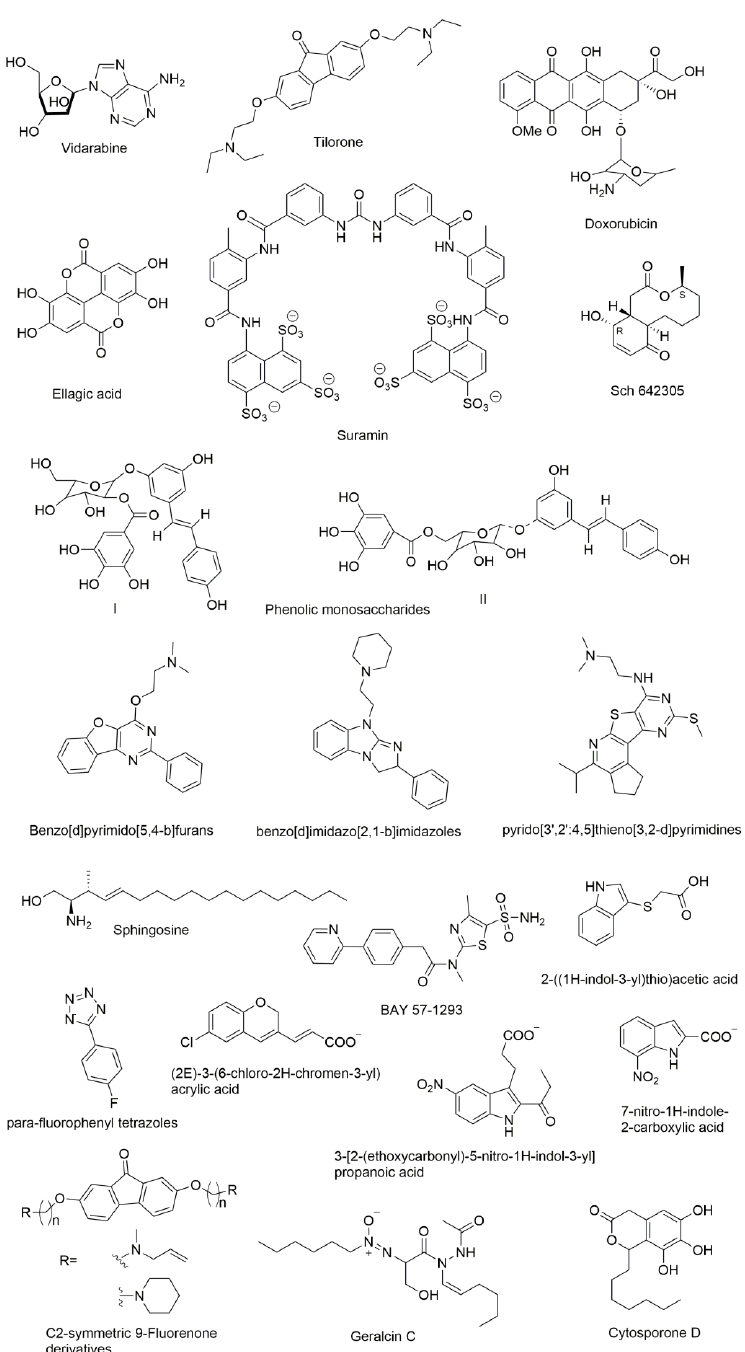
Figure 7. Chemical structures of DnaG primase inhibitors.